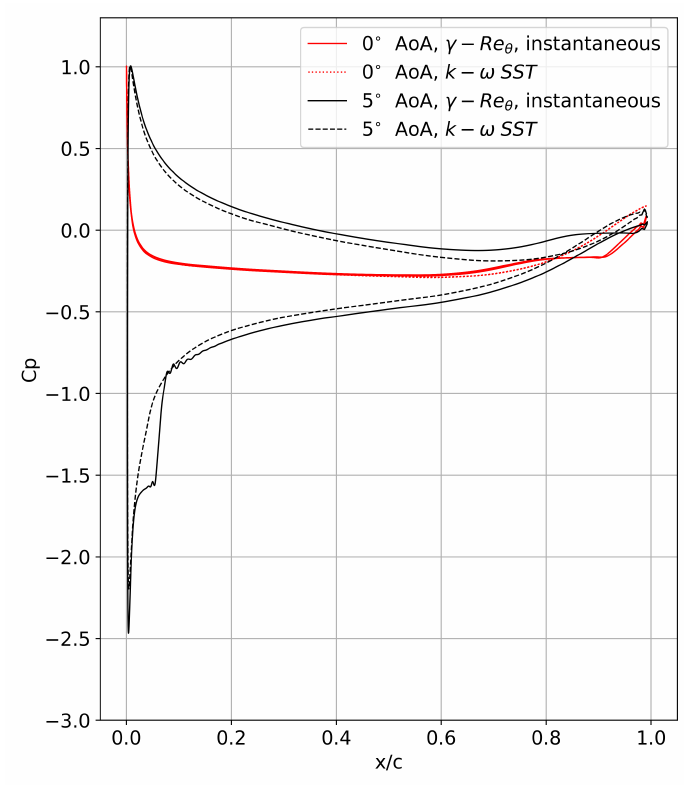
Figure 7. Predicted pressure coefficients at AoA of 0 ◦ and 5 ◦ , Re = 300,000.